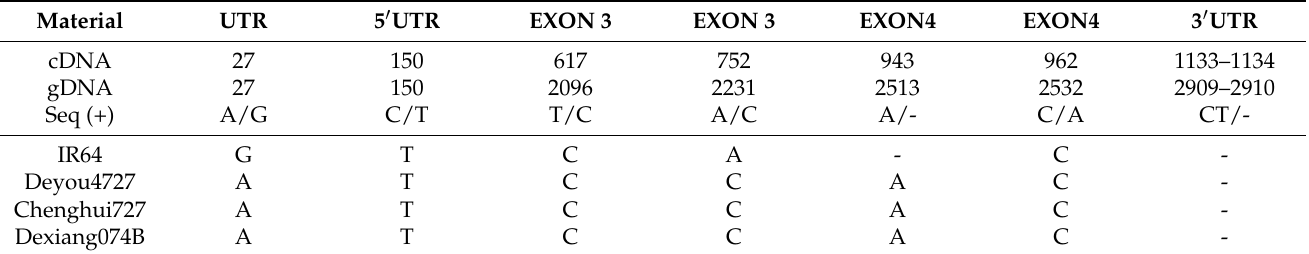
Table 3. The DRO1 sequence of Deyou4727, its parents, and IR64.